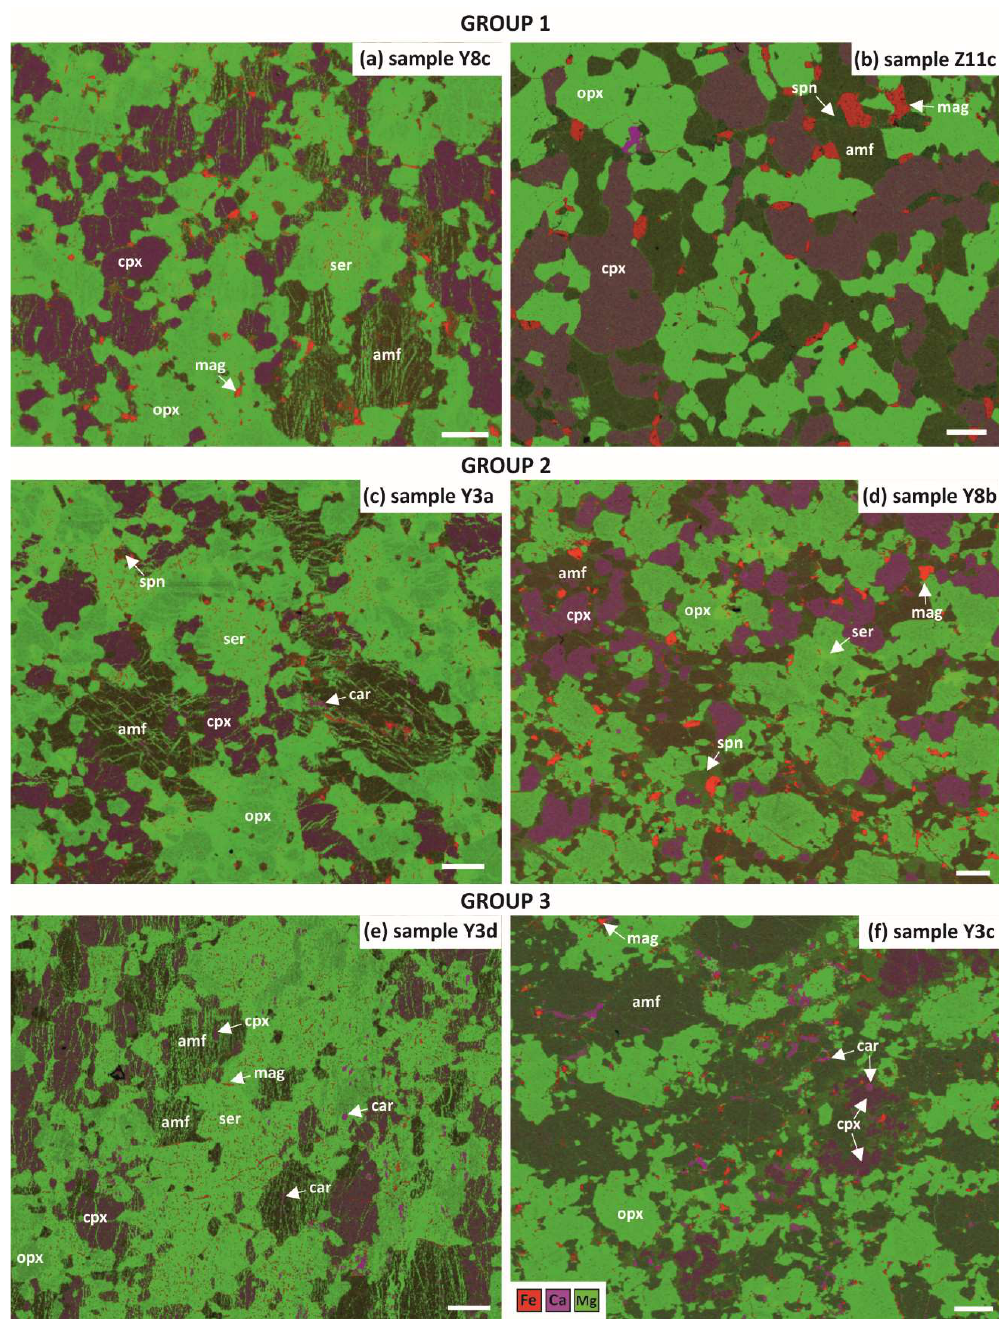
Figure 7. Element maps detailing the petrographic and textural characteristics of the Ben Strome ultramafics. ( a , b ) group 1 samples; ( c , d ) group 2 samples; ( e , f ) group 3 samples. Note the comparable textures between the geochemical groups. White scale bar = 1 mm. Abbreviations: amf = amphibole; car = carbonate phases; cpx = clinopyroxene; mag = magnetite; opx = orthopyroxene; ser = serpentine; spn =